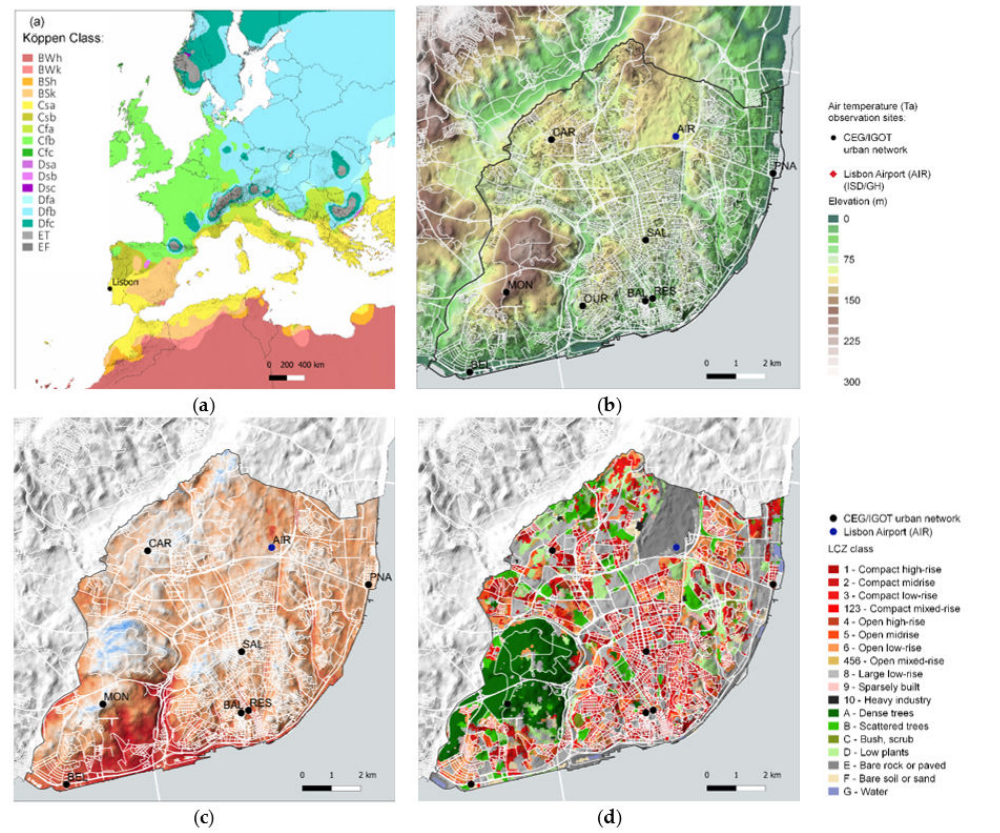
Figure 1. Air temperature (Ta) observation sites used in this study: Bel é m (BEL), Monsanto (MON), Alc â ntara (ALC), Campo de Ourique (OUR), Bairro Alto (BAL), Carnide (CAR), Saldanha (SAL), Restauradores (RES), Parque das Naç õ es (PNA) and Lisbon Airport (AIR). Base layers are: ( a ) Lisbon location over Köppen classification [1,2,43]; ( b ) Lisbon CEG/IGOT and AIR over terrain elevation [39]; ( c ) average north to northwest topographic exposure [40,41]; and ( d ) LCZ class